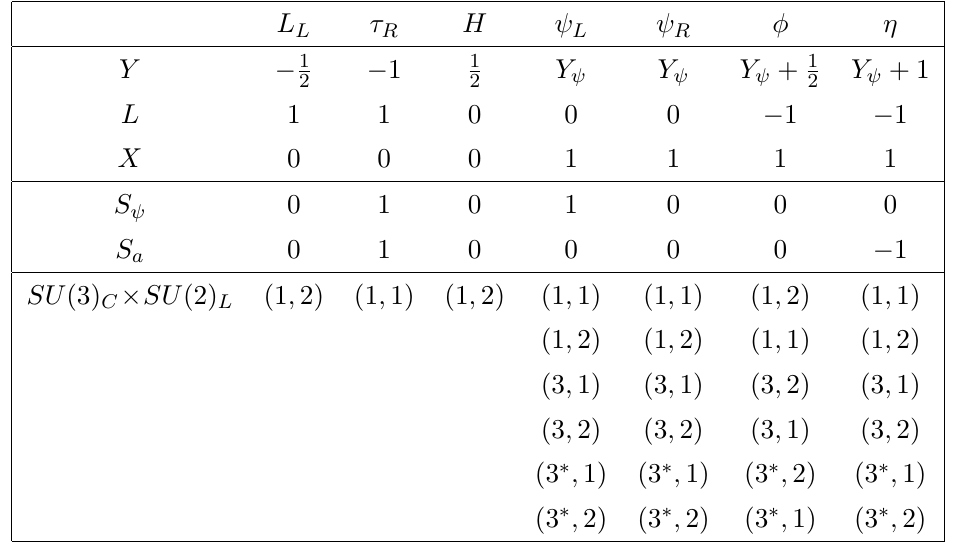
Table 2. Quantum numbers of fields for Class 1 τ -lepton models. The last six lines list the models containing only singlets and fundamentals under the SM gauge